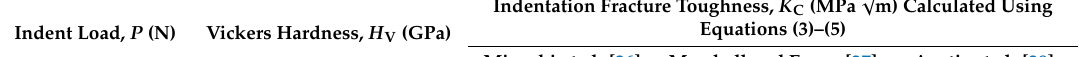
Table 6. Vickers hardness and indentation fracture toughness at various indent loads for the volcanic ash glass and synthetic sand and desert sand